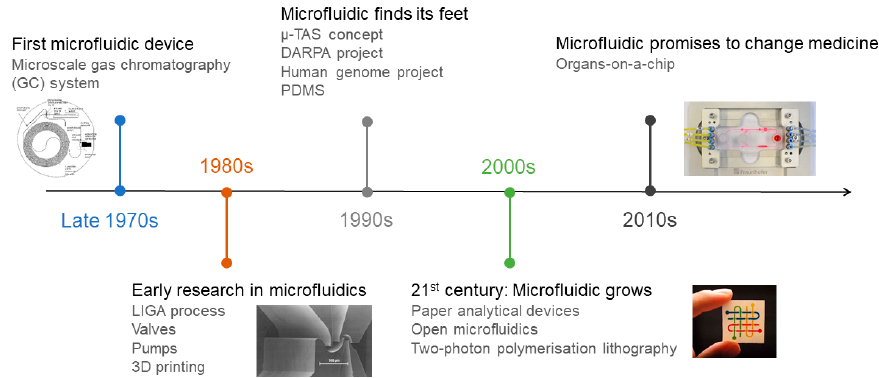
Figure 1. Timeline of the main microfluidics achievements from the first microfluidic device until the present.